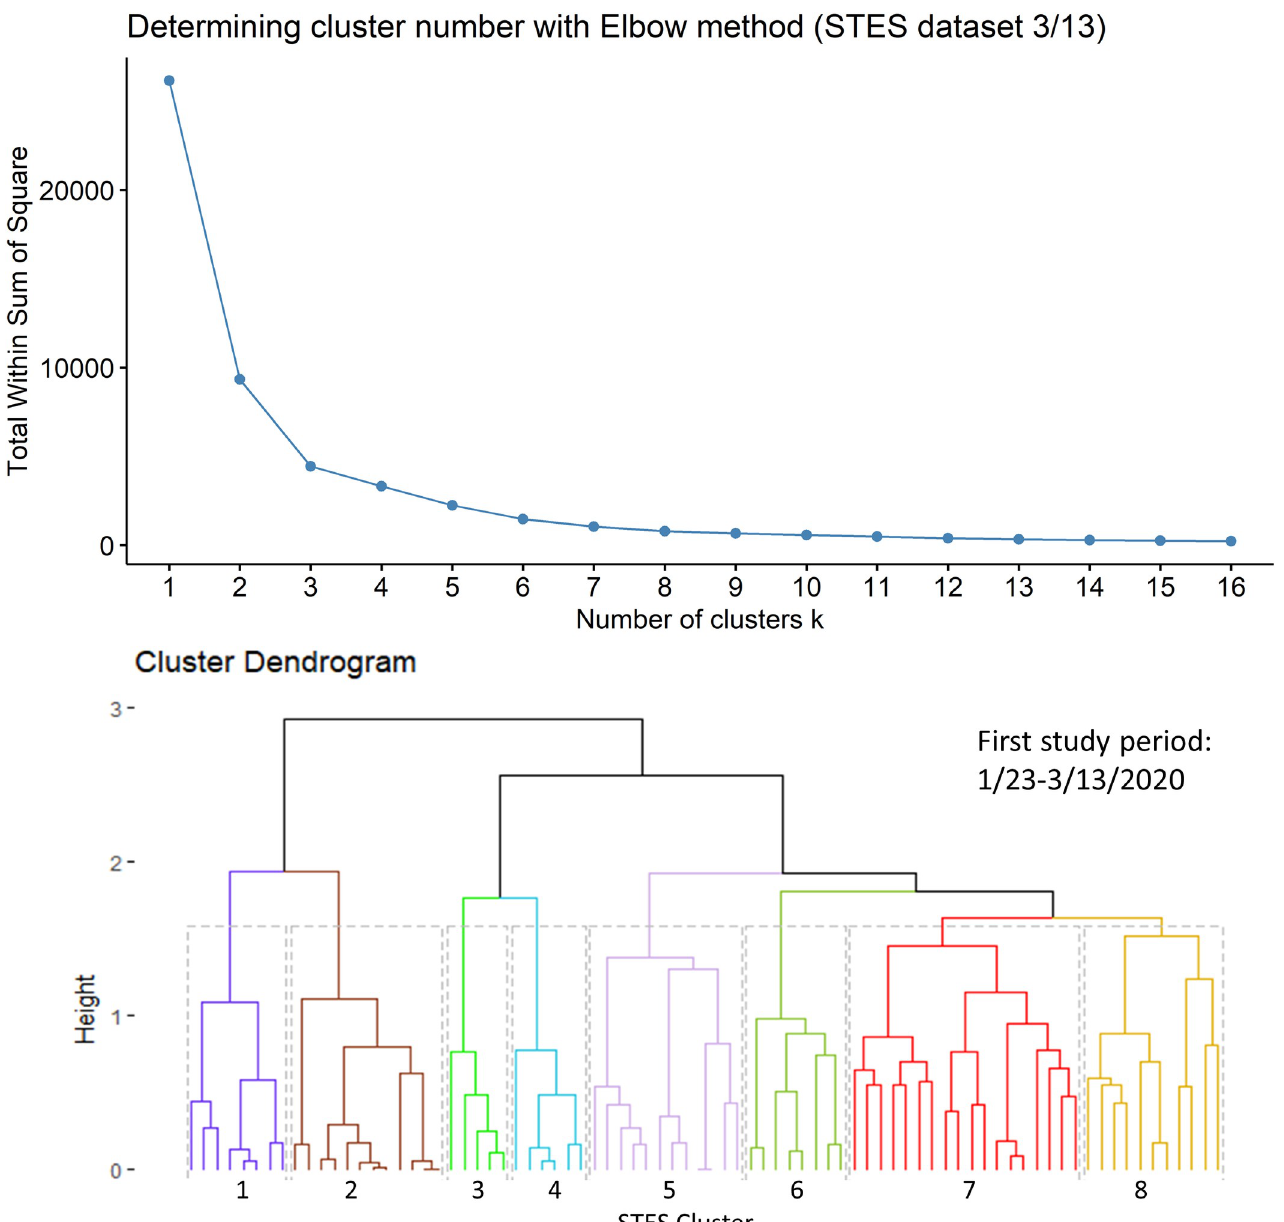
Fig 2. Elbow method evaluation and hierarchical clustering results for the 1st period. Notice that the numberings and colors of STES clusters match with those of corresponding clusters on the map and the temporal trend graph in Fig 3.